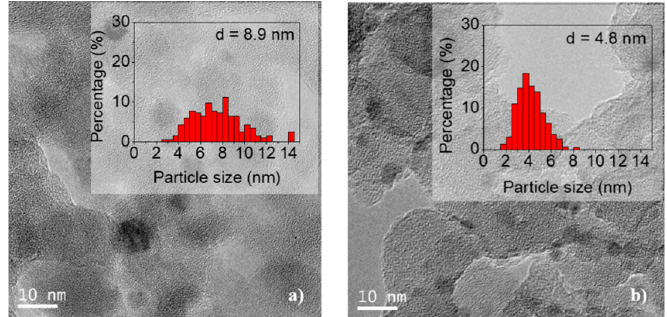
Figure 11. X-ray diffractograms of used Ni/SiO 2 and Ni/Ca(X)-SiO 2 catalysts. Figure 11. X-ray di ff ractograms of used Ni / SiO 2 and Ni / Ca(X)-SiO 2 catalysts.